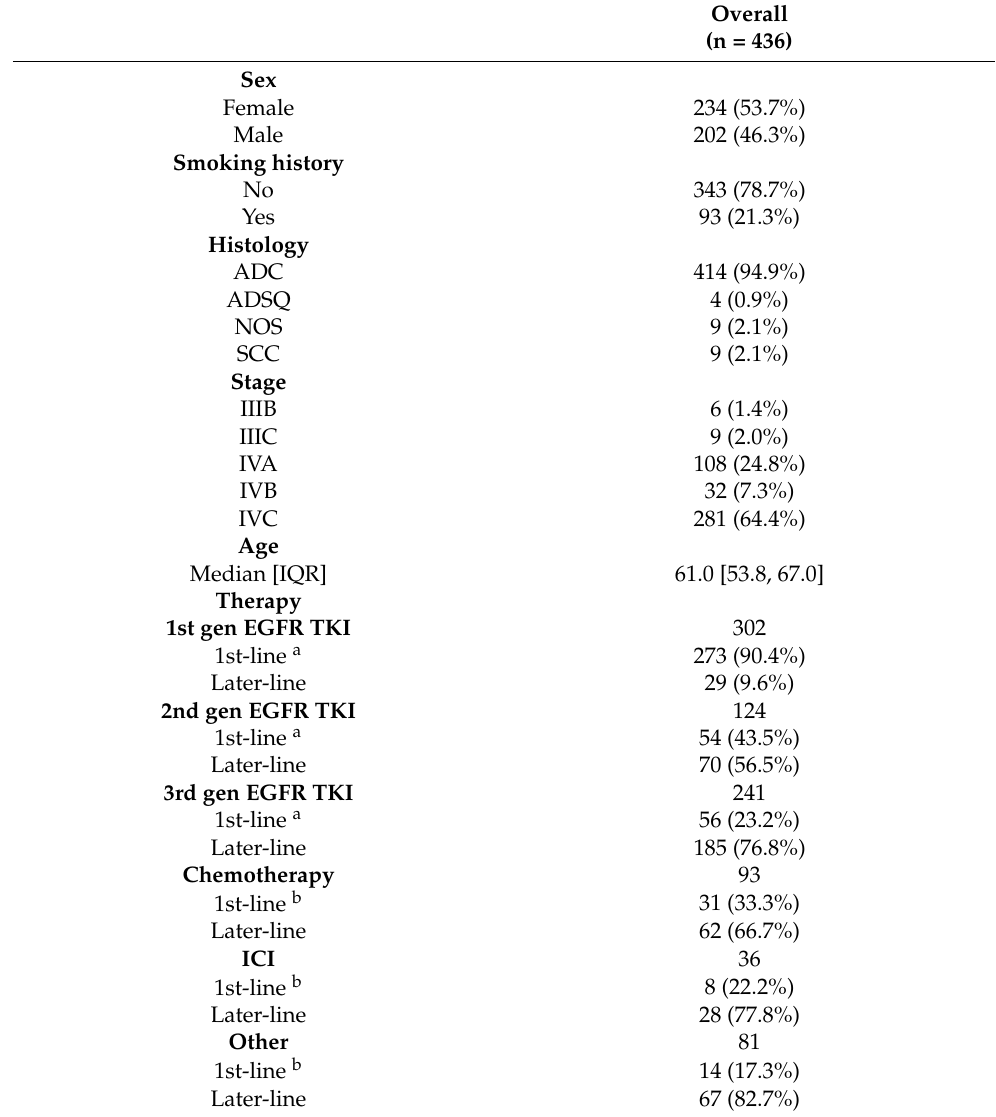
Table 1. Characteristics of patients for the survival